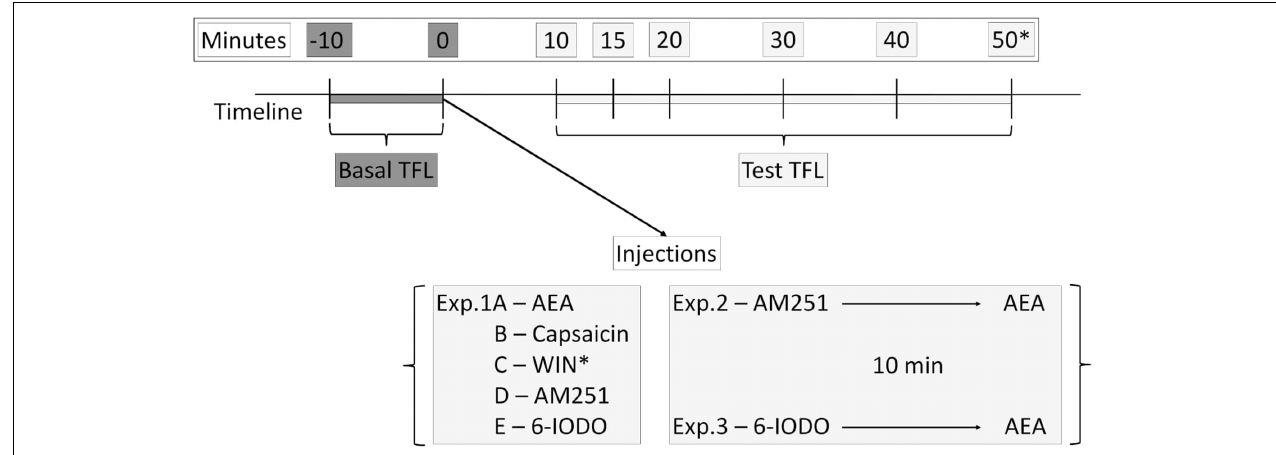
FIGURE 1 | Timeline of the tail-flick test showing basal TFLs (dark gray boxes) and test TFLs (light gray boxes) recordings as well as injection procedures performed at the Exps.